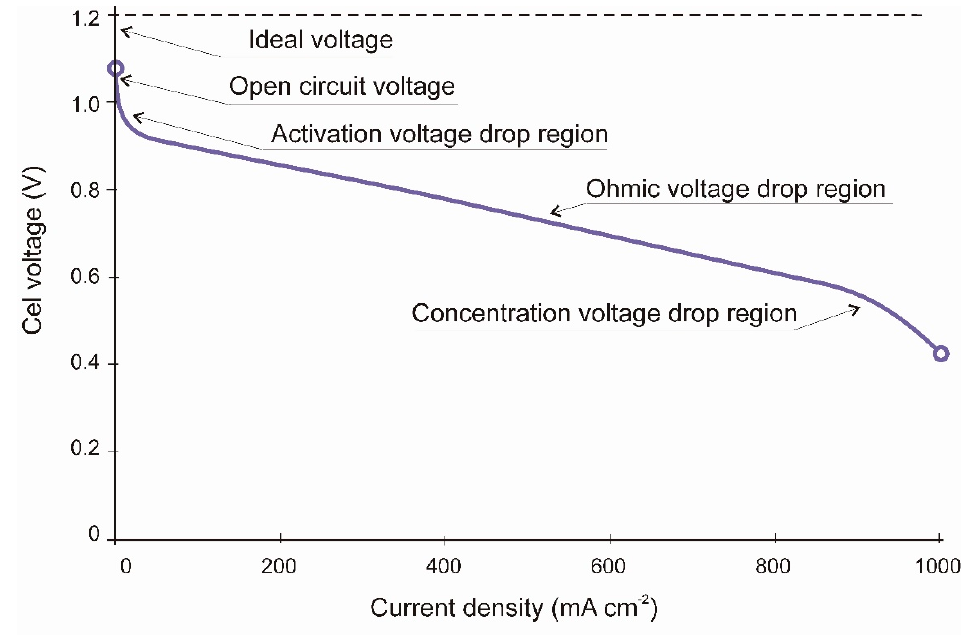
Figure 1. Typical PEMFC (Proton Exchange Membrane Fuel Cell) polarization curve.